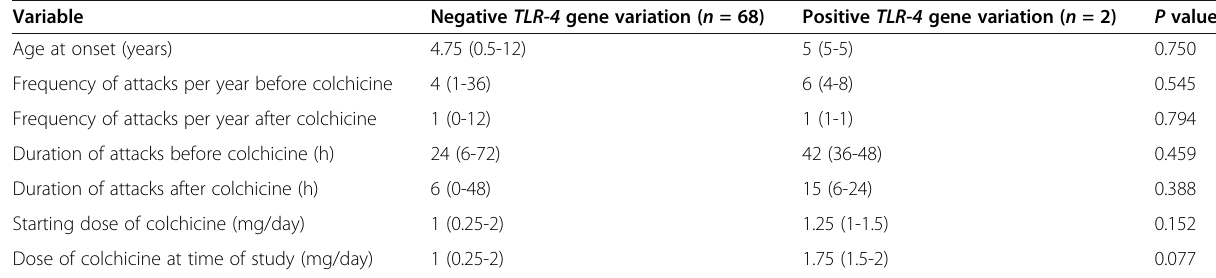
Table 5 Relation between TLR-4 gene variations and age at disease onset, frequency, and duration of attacks before and after colchicine therapy and colchicine